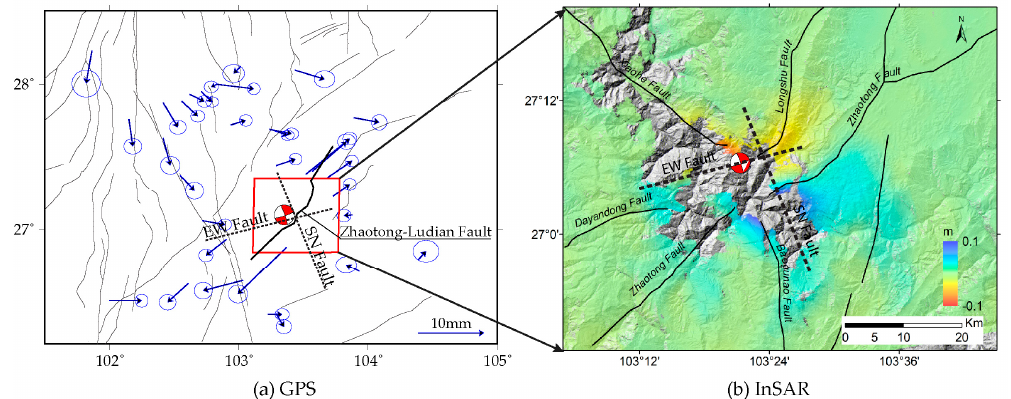
Figure 2. Coseismic deformation fields of the Ludian earthquake: ( a ) Coseismic horizontal displacements from the GPS measurements [17], with the red rectangle outlining the range of the 5- m resolution digital elevation model (DEM). ( b ) Coseismic line-of-sight (LOS) deformation field from the RADARSAT-2 data. The dashed lines in ( a ) and ( b ) indicate the inferred conjugate